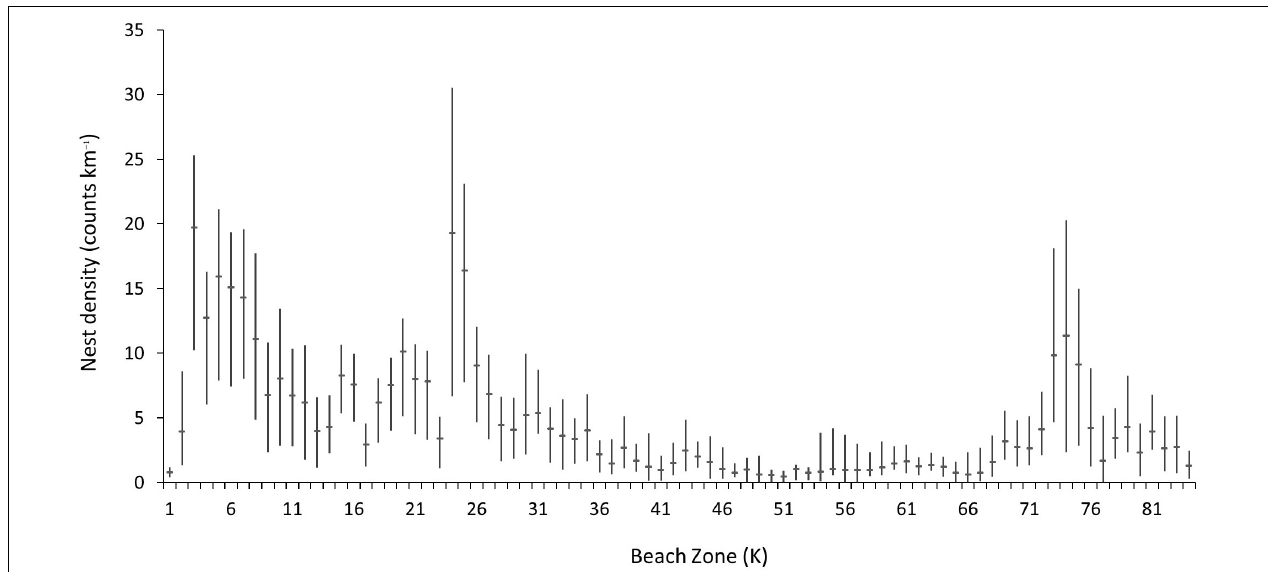
FIGURE 5 | Mean nest counts per kilometer (horizontal bar) and minimum and maximum annual means (vertical bar) for all survey beaches on Masirah (2008–2016).